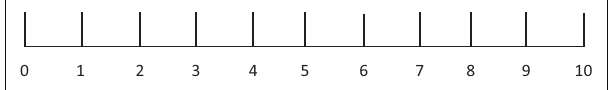
FIGURE 3-A1: SetlhabiSepe Sethlhabi se se tseneletseng (o thlabiwa ke setlhabi). The numerical visual analogue